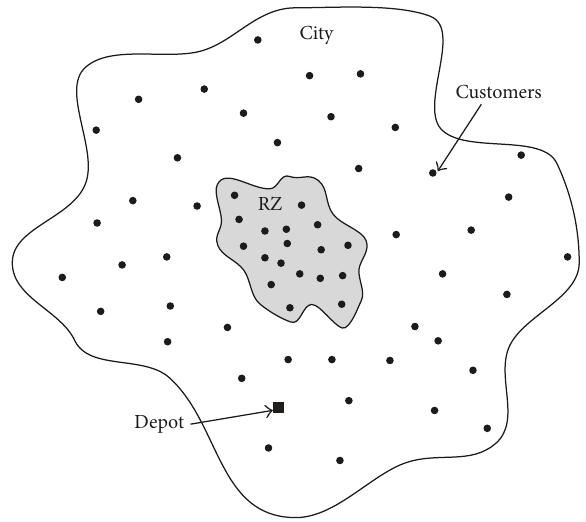
Figure 3: Schematic representation of a city with a restricted zone (RZ) subject to an access time window